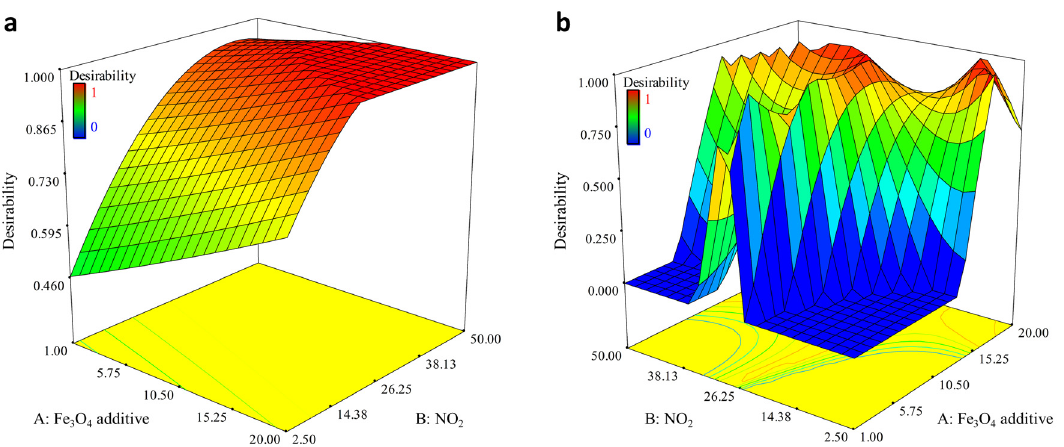
Figure 5. The desirability of the regression model for the prediction of ( a ) response time and ( b ) sensitivity.